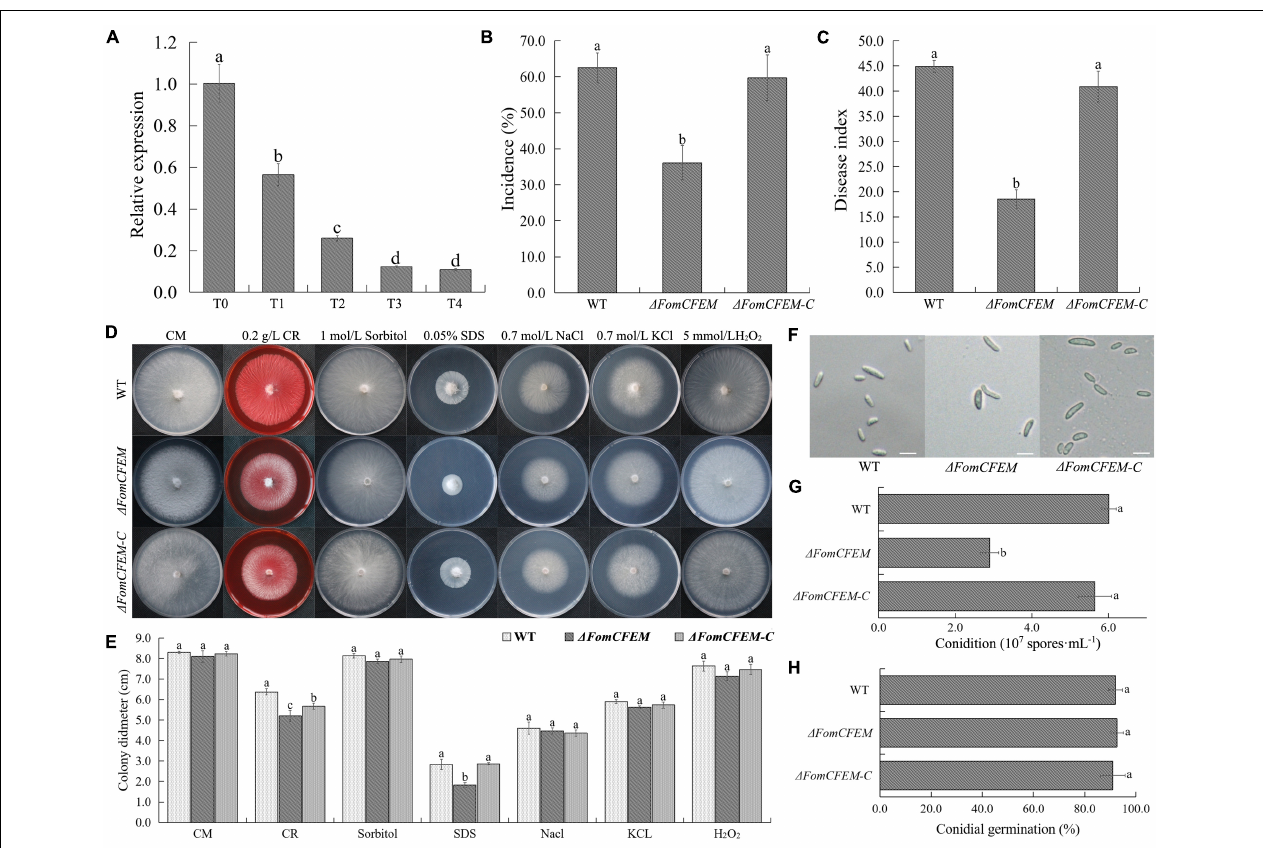
FIGURE 4 | Effect of TpQ2 on the expression of a protein with a CFEM domain ( FomCFEM ) in Fom and its function. FomCFEM contains a CFEM (common in fungal extracellular membrane) domain, which is conserved among some fungal extracellular membrane proteins and has eight characteristic cysteine residues in its N terminal region. (A) Effect of TpQ2 on the expression of FomCFEM during co-culture of TpQ2 and Fom. (B,C) Pathogenicity of the wild type Fom, (cid:49) FomCFEM deletion mutant, and (cid:49) FomCFEM-C complementation mutant in bitter guard plants. (D,E) Morphology and diameter of the of wild type Fom, (cid:49) FomCFEM deletion mutant, and (cid:49) FomCFEM-C complementation mutant on the CM, CM+0.2 g · L − 1 Congo red, CM+1 mol · L − 1 sorbital, CM+0.05% SDS, CM+0.7 mol · L − 1 NaCl, CM+0.7 mol · L − 1 KCl, and CM+5 mmol · L − 1 H 2 O 2 medium. Changes of colony morphology were used to show the sensitivities of the wild type Fom, (cid:49) FomCFEM deletion mutant, and (cid:49) FomCFEM-C complementation mutant to osmotic, cell wall-damaged and oxidative stresses. (F) Morphology of conidia of the wild type Fom, (cid:49) FomCFEM deletion mutant, and (cid:49) FomCFEM-C complementation mutant. (G) Conidiation of the wild type Fom, (cid:49) FomCFEM deletion mutant, and (cid:49) FomCFEM-C complementation mutant. Conidiation was determined after 5 days culture in 100 ml PDA culture medium. (H) Spore germination of the wild type, (cid:49) FomCFEM deletion mutant and (cid:49) FomCFEM-C mutant. Spore germination rates were determined at 12 h after culture at 25 ◦ C. Different letters in the same column indicate significant statistical difference at P < 0.05 level determined using the Student-Newman-Keuls test, the below is